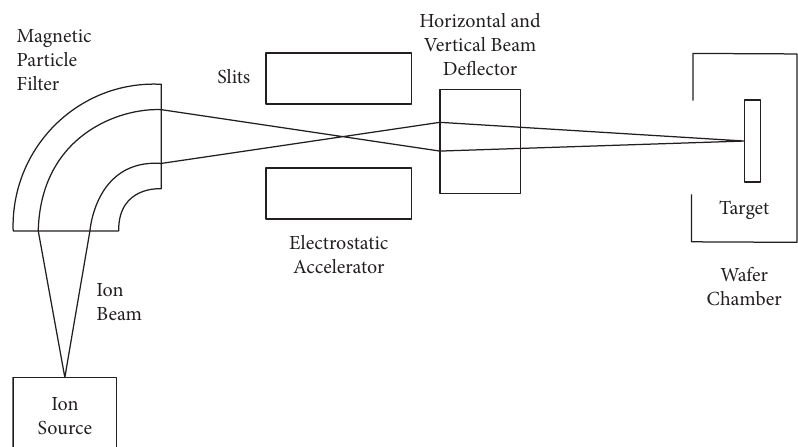
Figure 4: Schematic diagram of ion beam implantation technique.